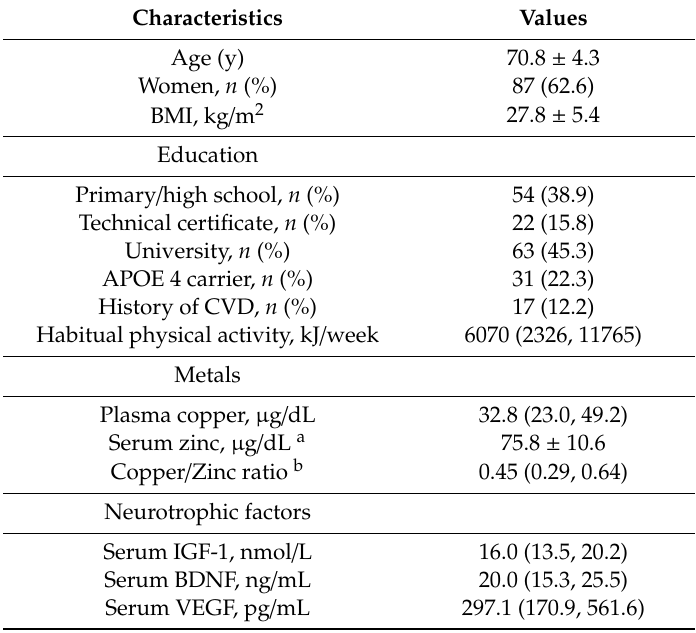
Table 1. Characteristics of study population ( n =